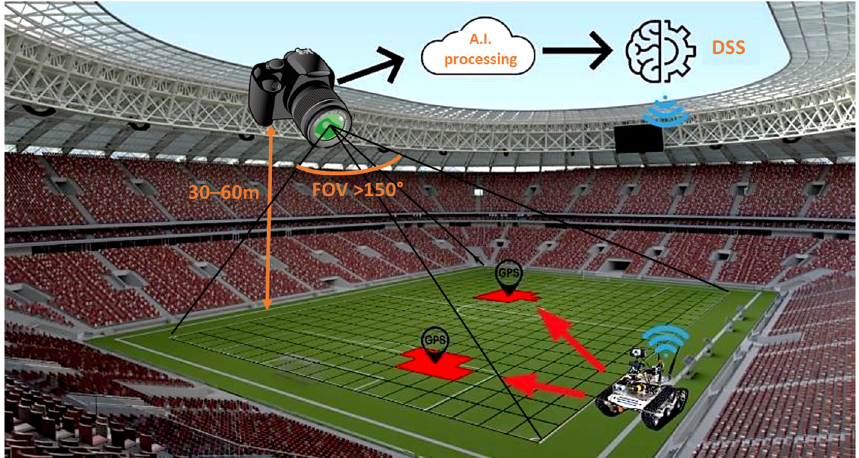
Figure 13. Sustainable and efficient turfgrass monitoring by integration of the multichannel camera within a fully robotized system, in combination with deep-learning processing and a decision-support system, a weather station, a mobile-sensing platform and an agriculture robot.